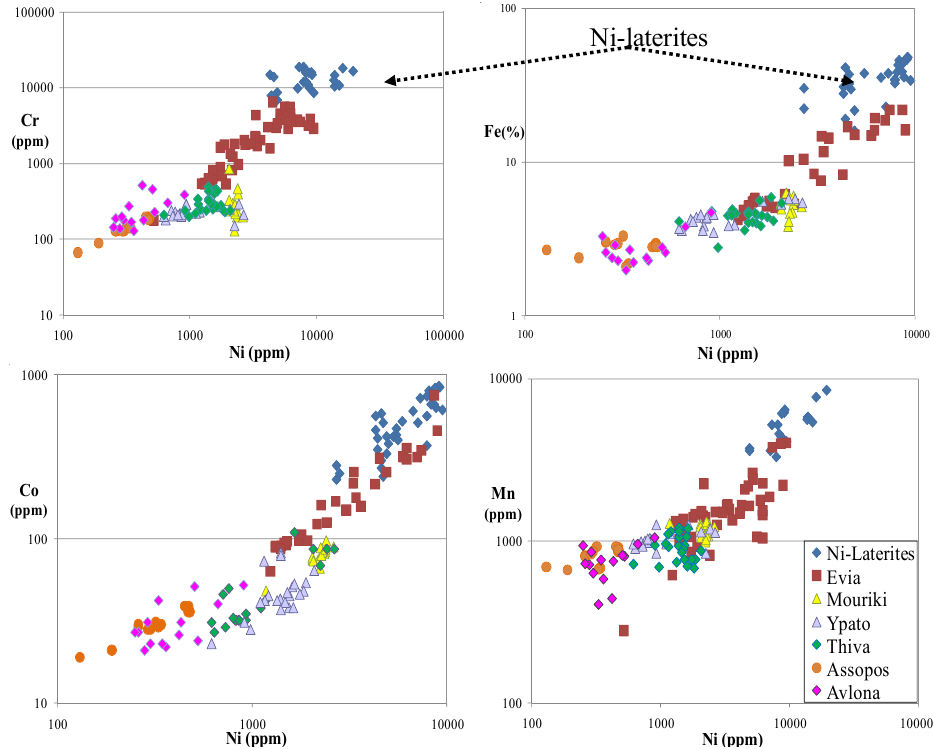
Figure 2. Variation of Cr, Fe, Co and Mn versus Ni contents in soils from the Assopos and Thiva basins, C. Evia and Ni-laterite deposits. There is an increasing trend from the Assopos basin to Evia, which is in a close proximity with Ni-laterite deposits. Data from